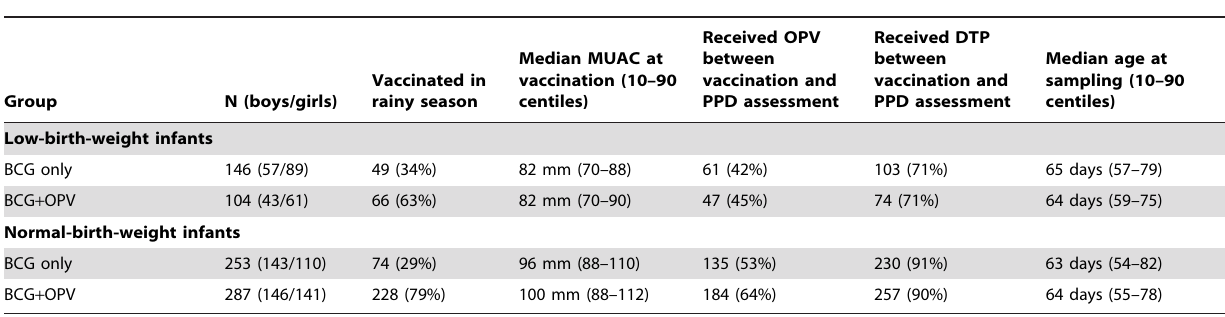
Table 2. Description of the scar and PPD study population. Group